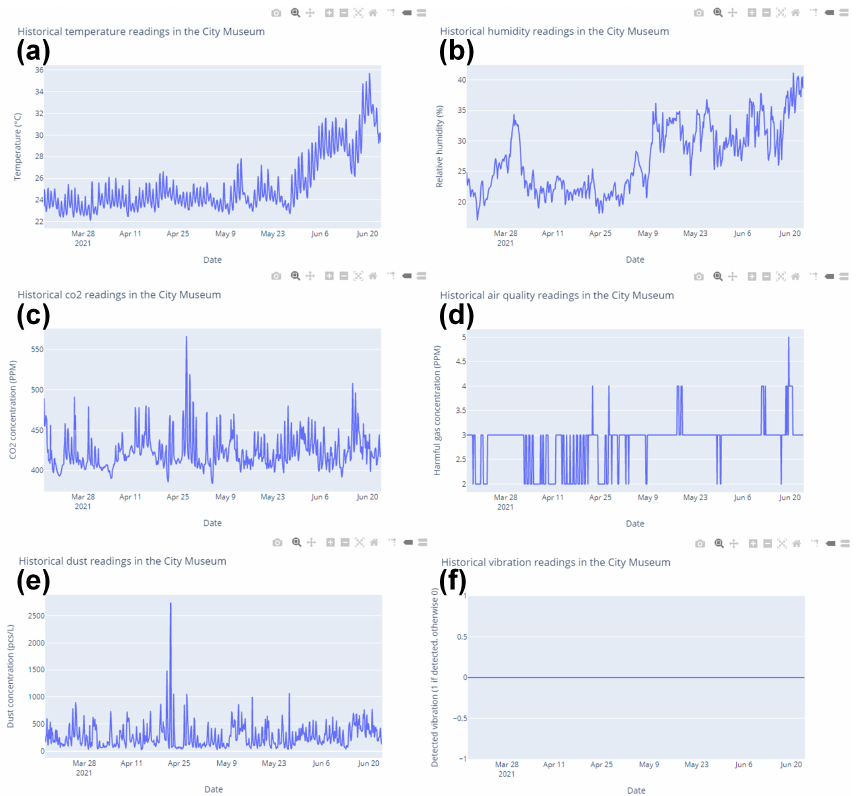
Figure 9. Historical sensing data collected in the City Museum from 16 March to 23 June 2021. ( a ) Temperature, ( b ) relative humidity, ( c ) CO 2 concentration, ( d ) harmful gas concentration, ( e ) dust concentration, and ( f ) vibration.